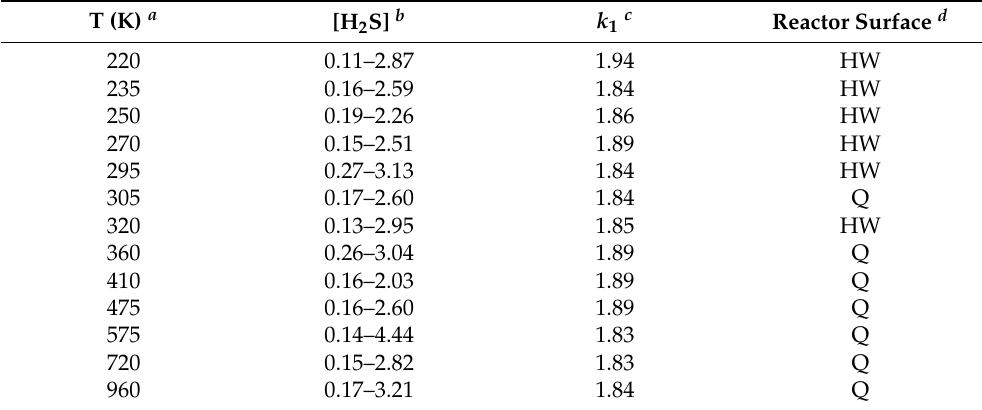
Table 1. Experimental conditions and results of the measurements of the rate coefficient of reaction (1). T (K)